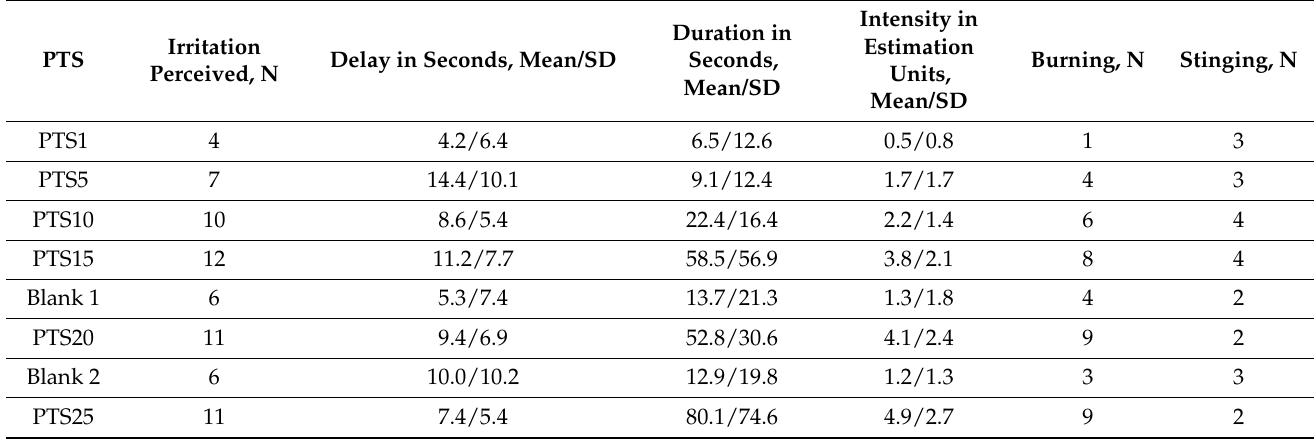
Table 3. Psychophysiological responses to piperine impregnated taste strips (PTS) and blanks of Experiment 1 (n =